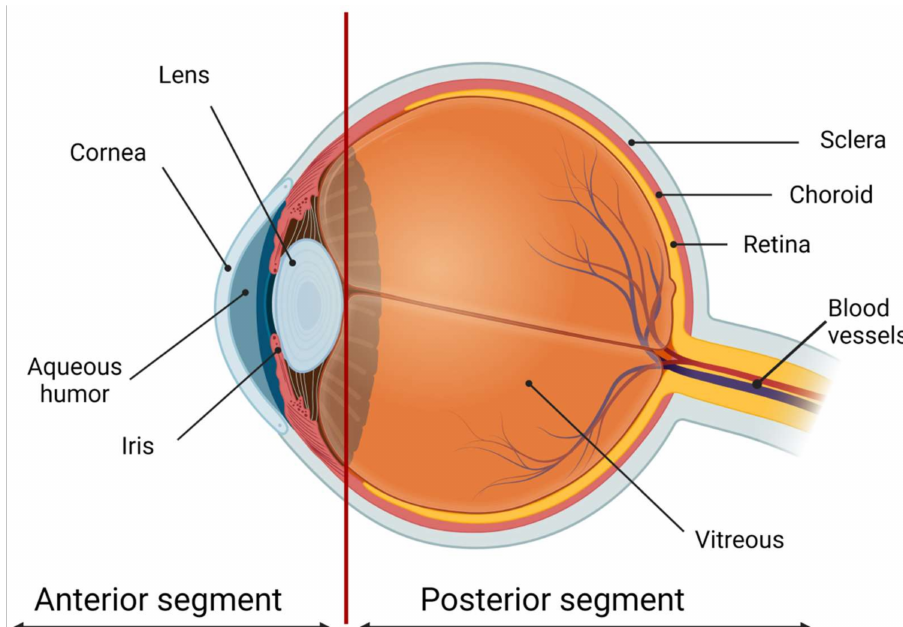
Figure 1. The scheme of the eye. The ocular globe can be conditionally divided into two parts: the anterior segment and the posterior segment. The anterior eye segment consists of the cornea, conjunctiva, iris, ciliary body, lens, and aqueous humor, while the sclera, choroid, retina, and vitreous body form the posterior segment. Created with